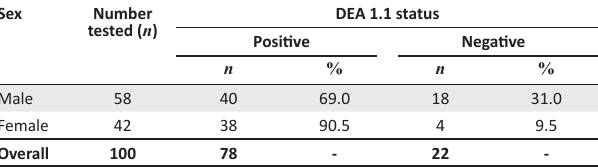
FIGURE 1: Population pyramid showing the age of dogs in months, with males and females separated. TABLE 1: Prevalence distribution of dog erythrocyte antigen 1.1 according to sex in dogs sampled from